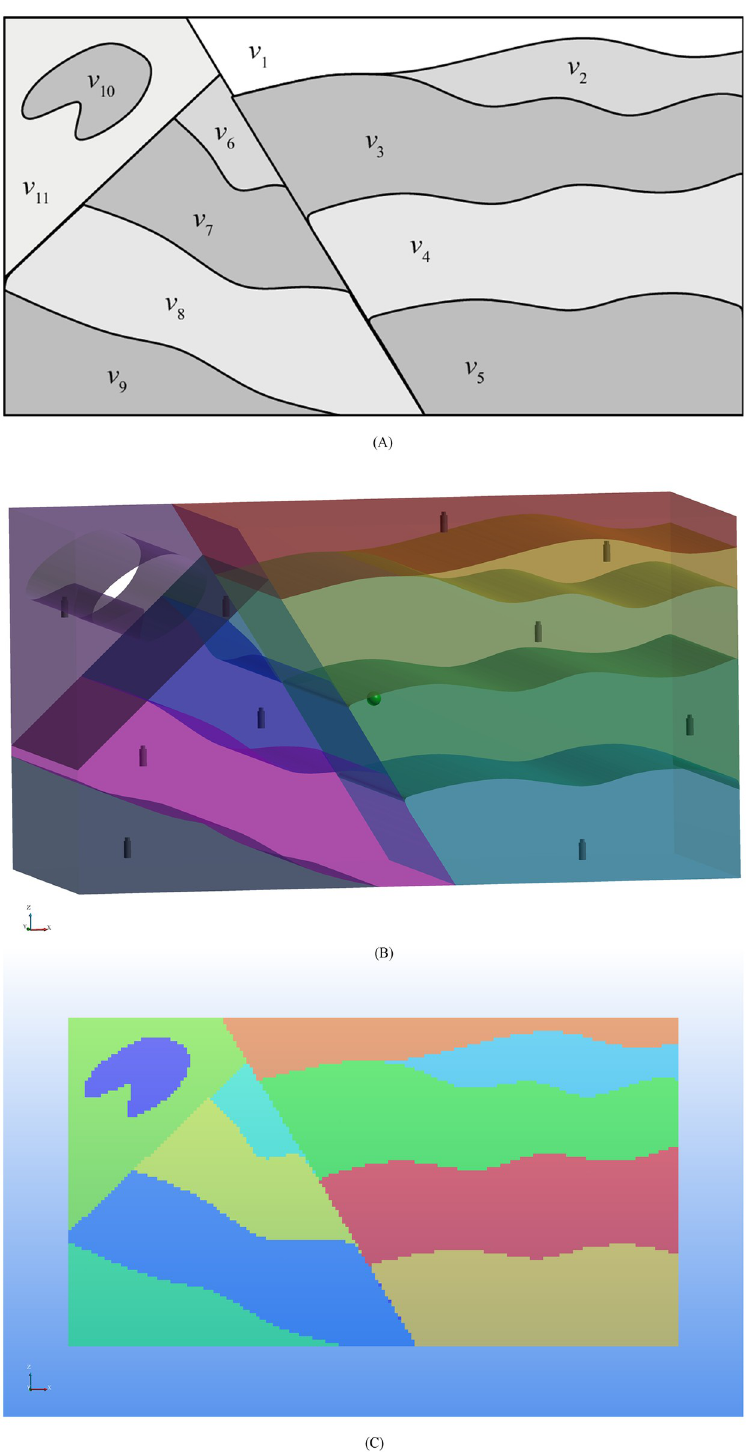
Fig 7. A complex synthetic velocity model. (A) The original 2D laterally heterogeneous velocity model presented by Rawlinson et al. (B) The 3D geological model constructed based on (A). (C) Front view of the 3D velocity model.